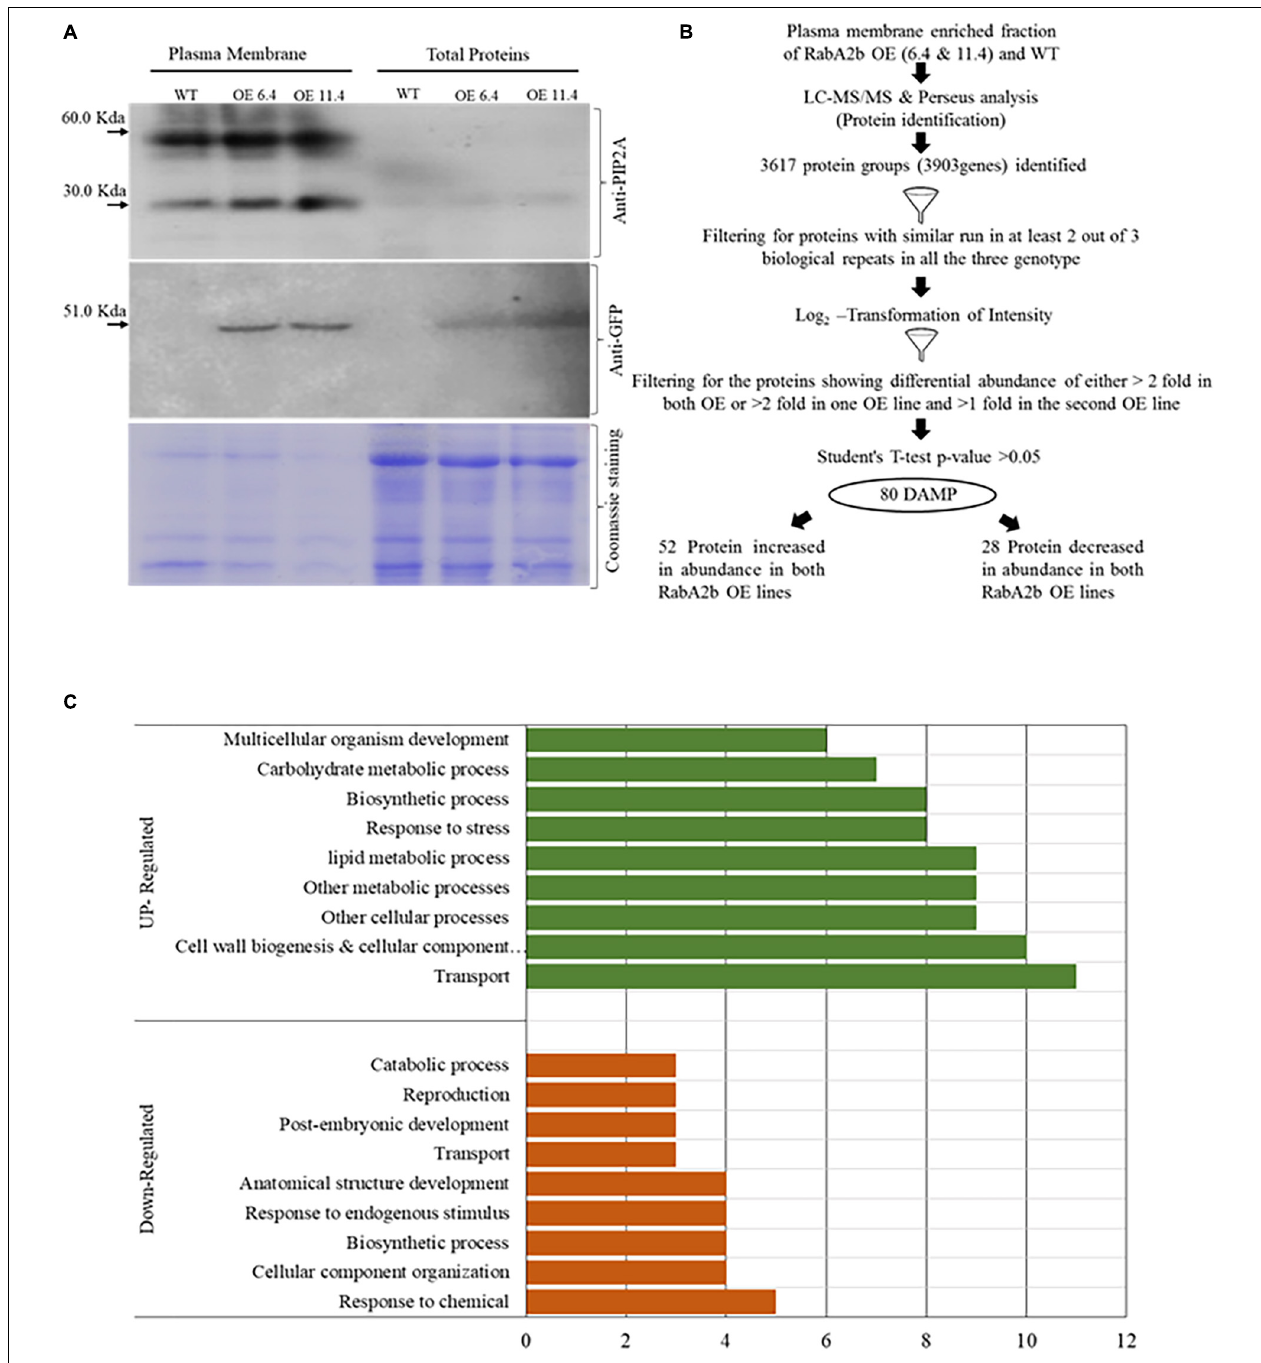
FIGURE 7 | Proteomics of PM enriched fractions in wt and RabA2b overexpressing plants. Total protein and Plasma membrane (PM) enriched fractions were isolated from 11-day old wt and two RabA2b OE lines. The isolated proteins were separated by SDS-PAGE and probed with antibodies against PIP2A and GFP. (A) Western blot developed using anti-PIP2A antibody, showing two bands representing the dimeric (52 kDa) and monomeric (30 kDa) forms of PIP2A and 51 kDa band probed by anti-GFP antibody, represents the combined mass of chimeric RabA2b:GFP protein. In addition, shown is Coomassie staining for equal loading of PM-enriched fraction and total protein isolated form mentioned above genotypes. (B) Flowchart for the LCMS/MS-based proteomics study of these PM-enriched fractions. The identified protein group were first filtered for their consistent presence or absence in at least 2 out of 3 biological repeats in all three genotypes. The second filter was applied for Log2 transformed intensity. A total of 80 proteins were identified showed differential abundance of either > 2 fold in both OE or > 2 fold in one OE line and > 1 fold in the other OE line. (C) Gene Ontology (GO) enrichment analysis of the DAMP for Biological Process in the OE lines. The Bar graph represents the biological functions of the genes corresponding to DAMP proteins with increased (upregulation) and decreased abundance (downregulation). The GO analysis was done using “TAIR GO” annotation search and “AgriGo” https://www.arabidopsis.org/tools/bulk/go/index.jsp.